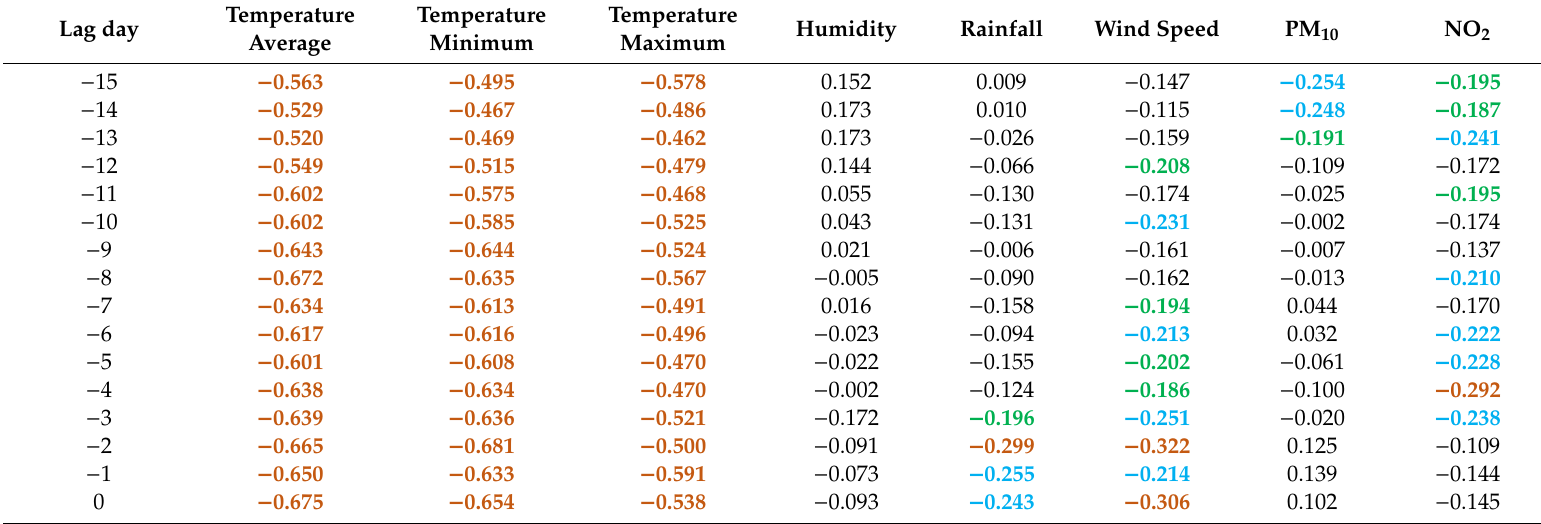
Table A4. Empirical results through Spearman rank correlation test for mortality in CABA, from lag of 15 days prior to the confirmation date (lag 0). Number colors indicate stands for 1% , 5% , and 10% level of significance,